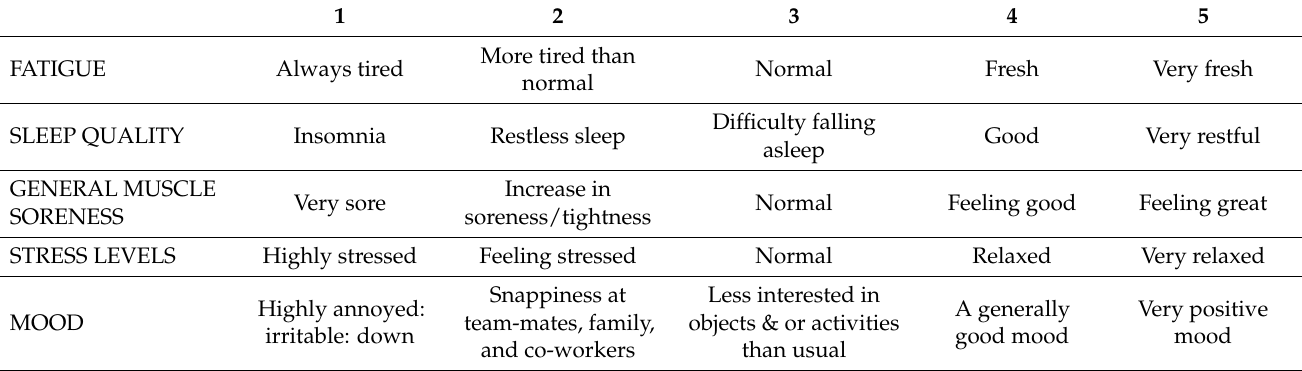
Table 1. The well-being questionnaire that was completed during the study